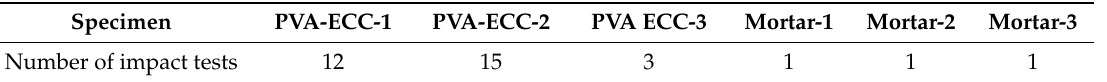
Table 6. Total number of the impact tests for each beam